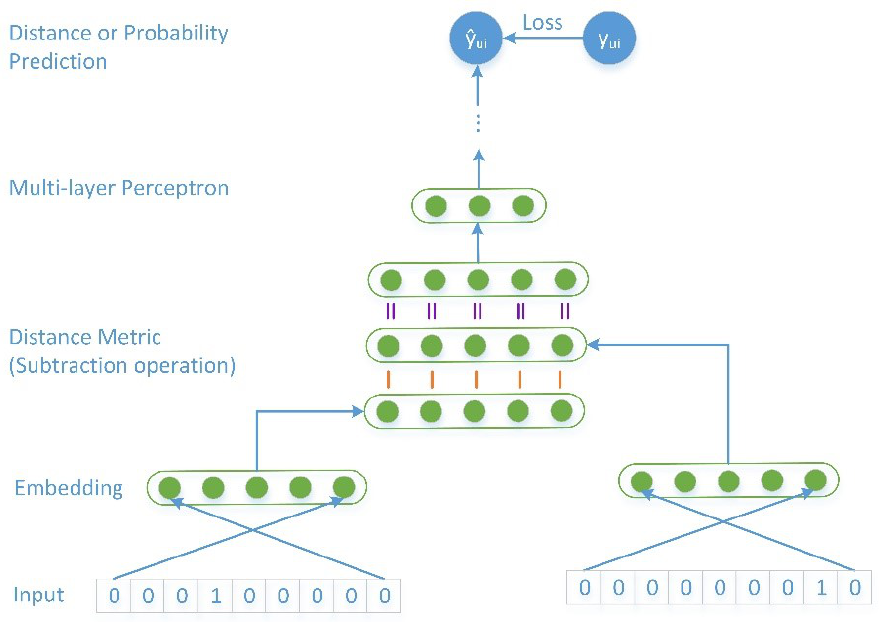
Figure 4. The framework of neural metric factorization, where ˆ y u , i represents the predicted distance in the rating prediction task or the predicted probability in the item ranking task. y u , i represents the true distance in the rating prediction task or the true hit probability in the item ranking